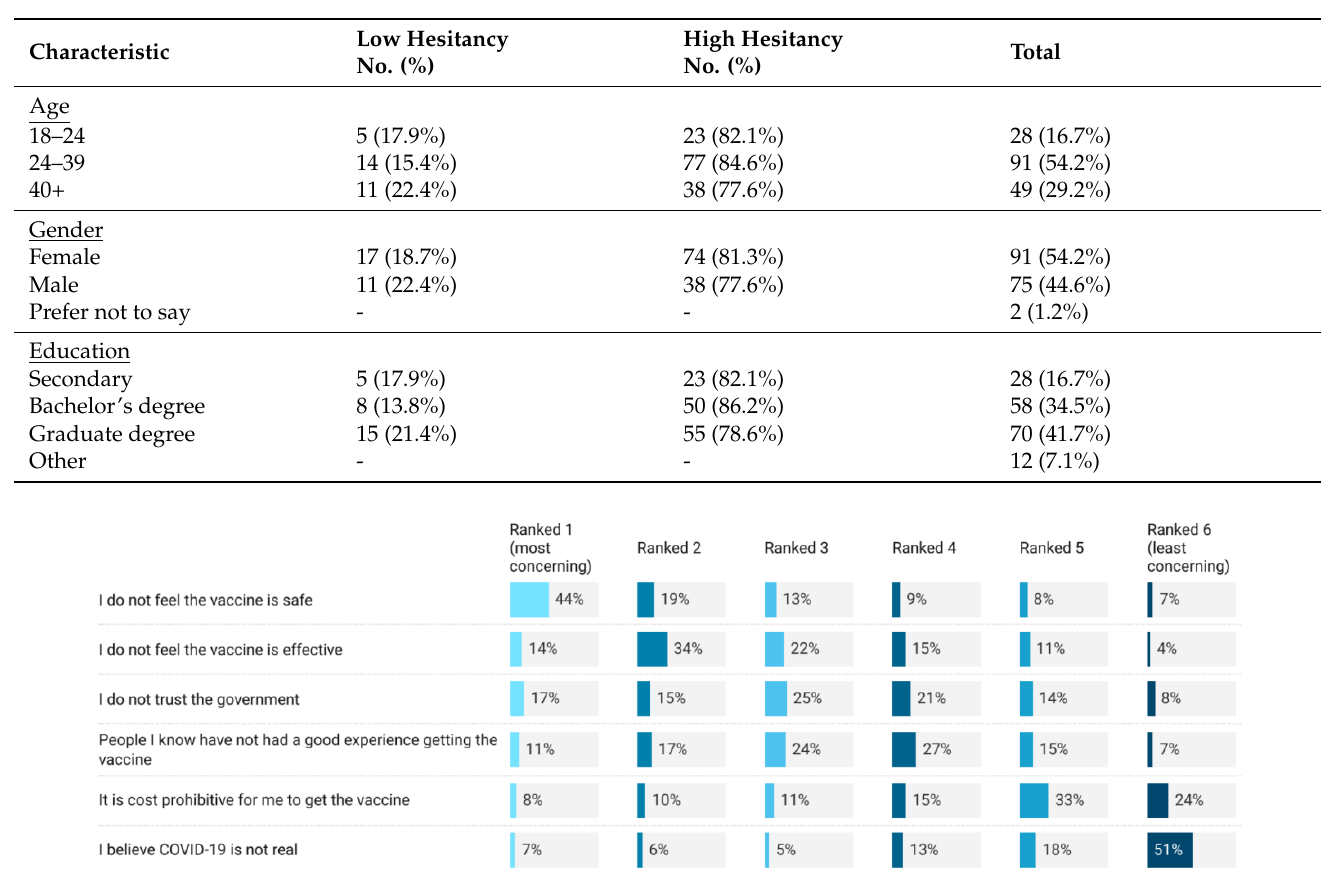
Table 2. Participant characteristics and vaccine hesitancy.